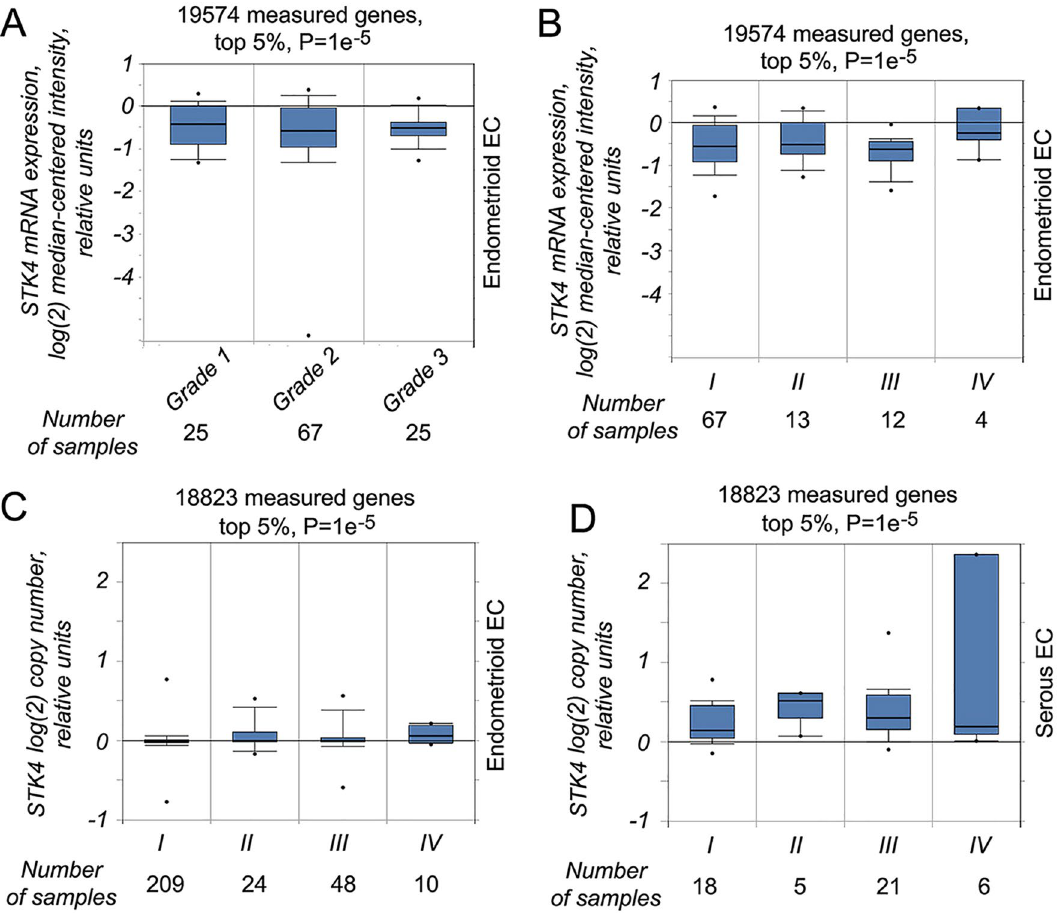
Figure 3. STK4 gene expression pattern, obtained at the Oncomine portal. ( A ) STK4 mRNA expression in endometrioid tumors in relation to the grade; ( B ) as in ( A ), related to the stage; ( C ) STK4 gene copy number related to the different stages of endometrioid ECs; ( D ) as in ( C ), but of serous